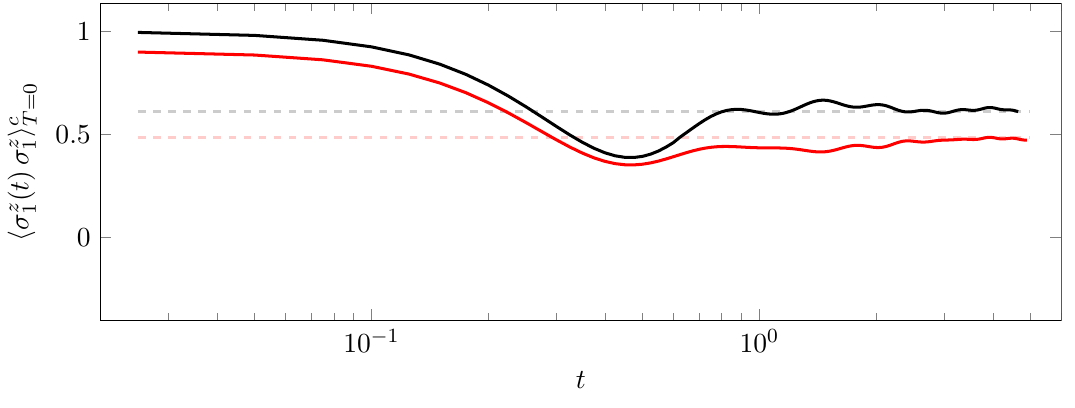
( t ) σ z 〉 c vs. time t T = 0 1 1